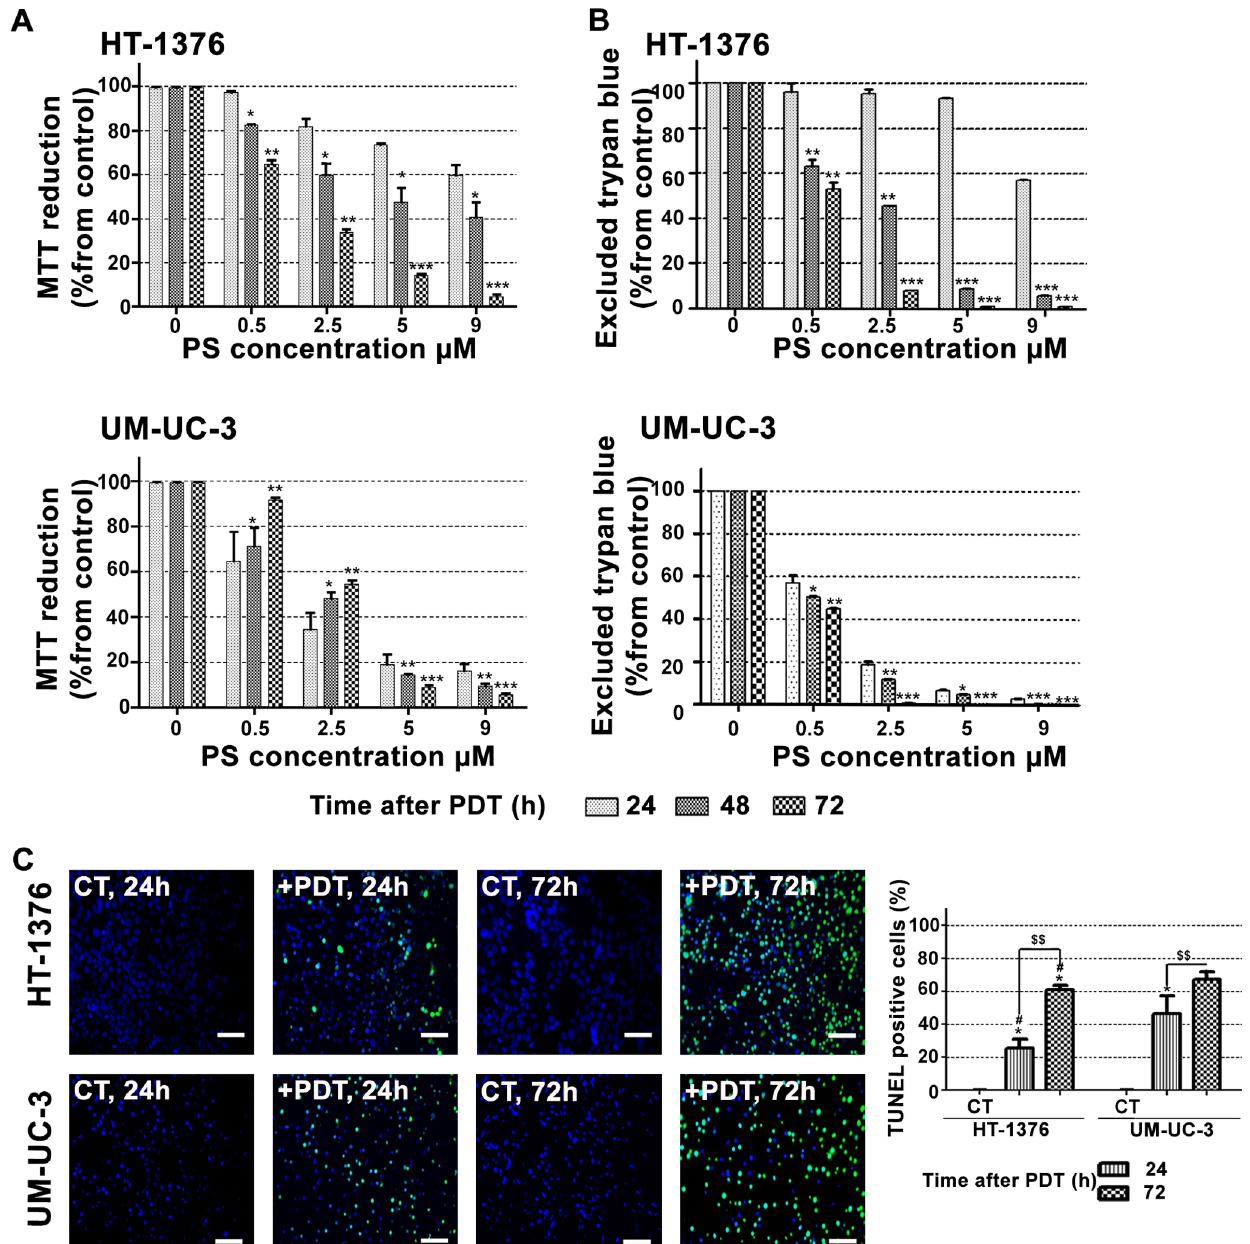
Figure 3. PDT with PcGal 16 has a long-term phototoxicity effect. Cytotoxicity was assessed 24, 48, and 72 h after PcGal 16 -PDT using the MTT (panel A) and trypan blue staining (panel B) assays. The percentage of cytotoxicity was calculated relatively to control cells (cells incubated with PBS in darkness and then irradiated) at the respective uptake time. Data are the mean value 6 S.D. of at least three independent experiments performed in triplicates. *(p , 0.05), **(p , 0.001), ***(p , 0.0001) significantly different from MTT reduction (%) or excluded trypan blue (%) at 24 h after PDT for the respective concentration. Representative fluorescence images revealing cell death in HT-1376 and UM-UC-3 cells after PDT with PcGal 16 by TUNEL staining 24 and 72 h after treatment (panel C). DAPI was used for nuclei staining (blue) and TUNEL staining was used to visualize dead cells (green). Scale bars 20 m m. Quantification of TUNEL-positive cells 24 and 72 h after PDT with PcGal 16 . *(p , 0.05) significantly. different from control cells. $$ (p , 0.001) significantly different from TUNEL-positive cells 24 h after PDT. # (p , 0.05) significantly different from TUNEL-positive UM-UC-3 cells at the respective time after PDT.